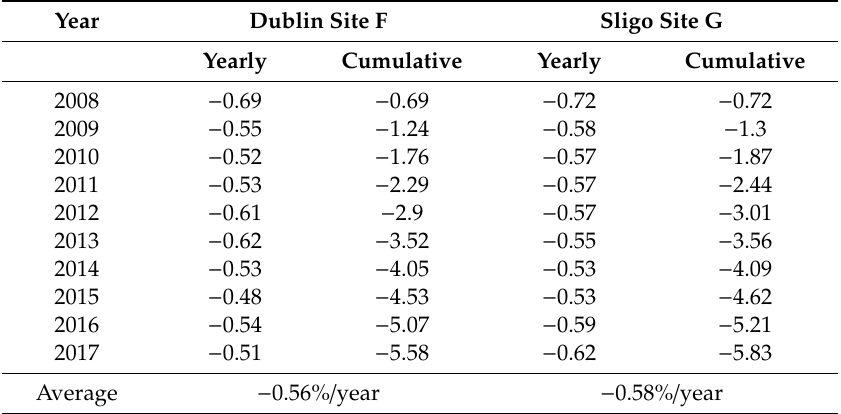
Table 5. Ireland PV systems’ Degradation